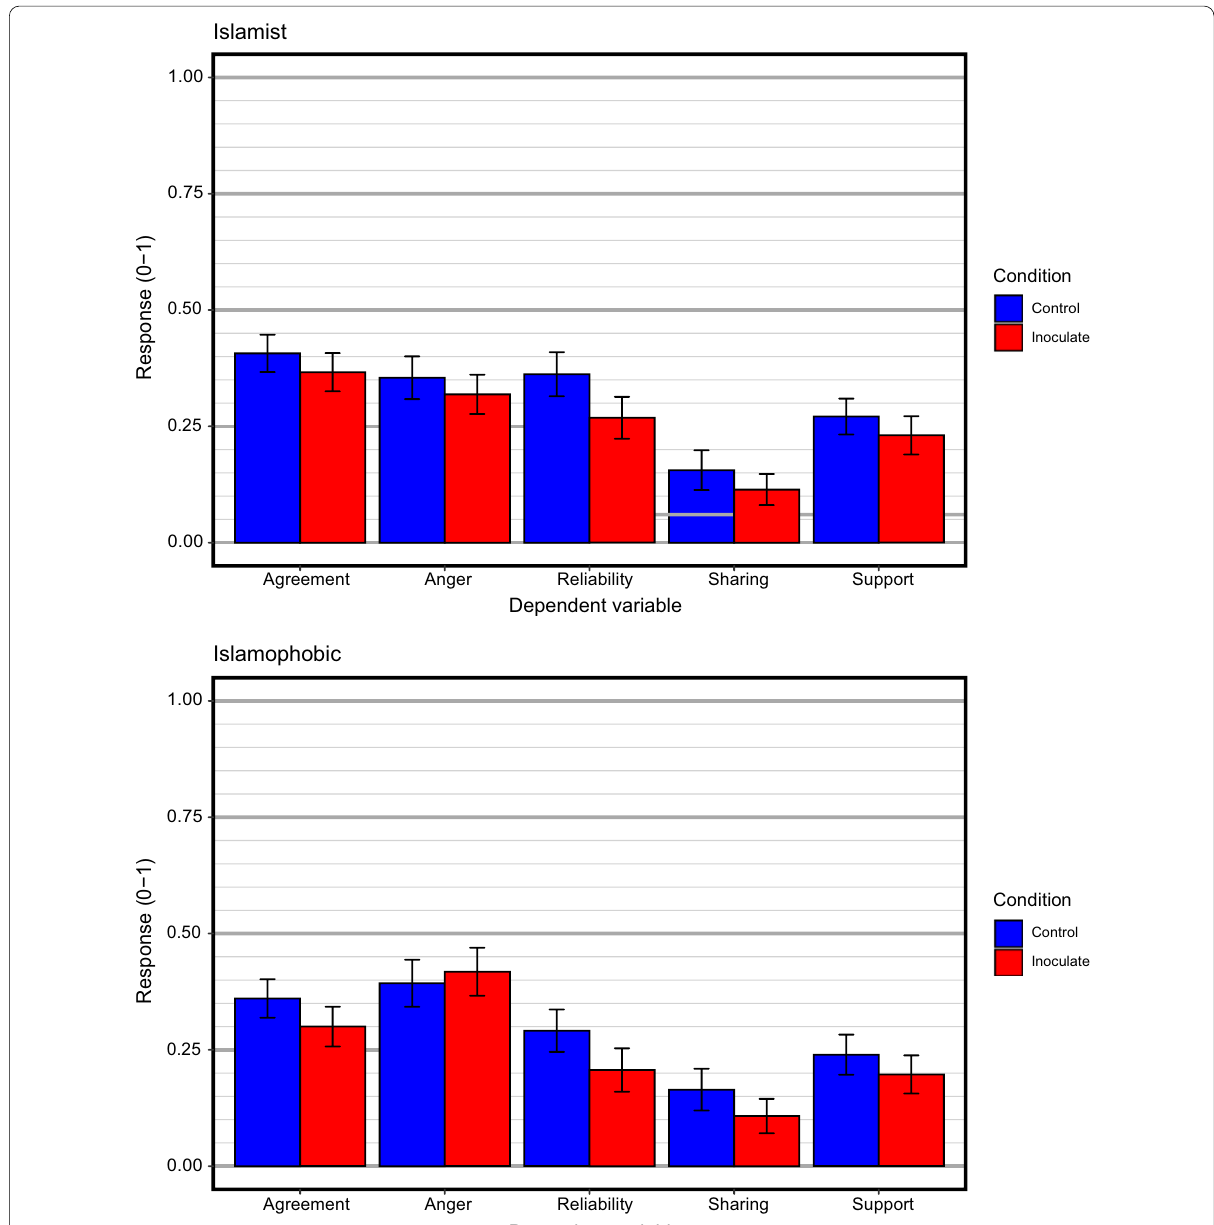
Fig. 3 Summary of main dependent variables for all conditions. The top panel is for the Islamist target video and the bottom panel for the Islamophobic target video. All dependent variables are rescaled to the range 0 to 1 for commensurability. Error bars represent 95% confidence